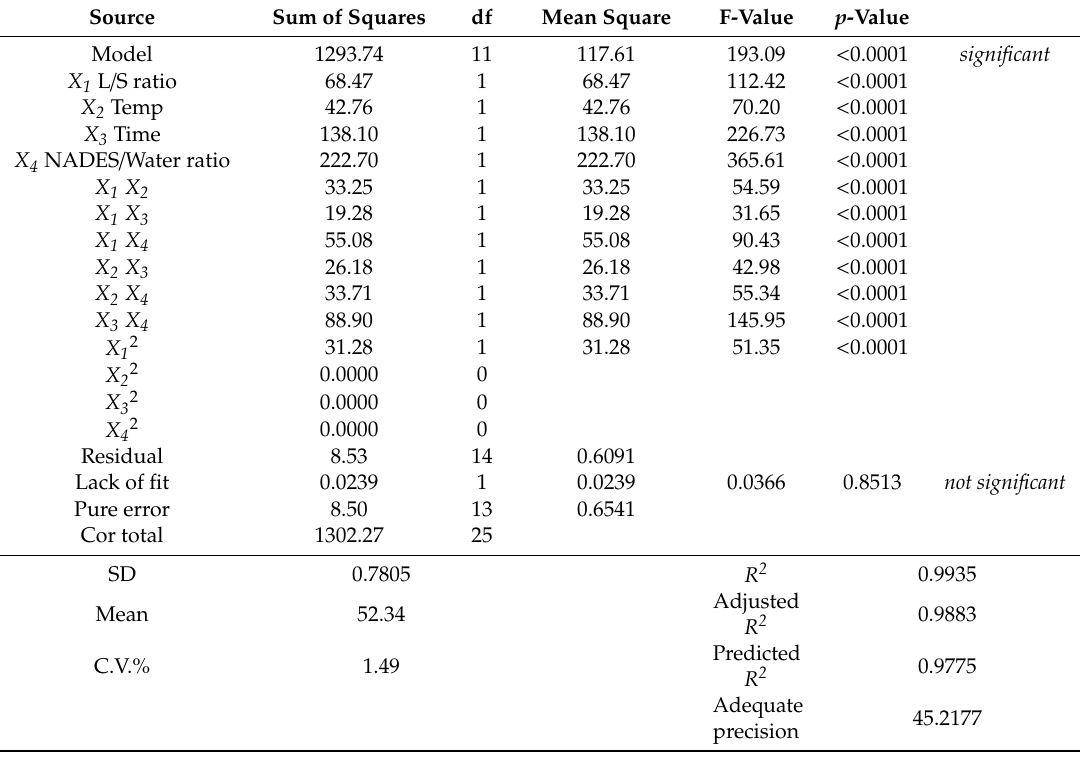
Table 5. Analysis of variance (ANOVA) for DSD for DE% using ChCl–Mal and its fit